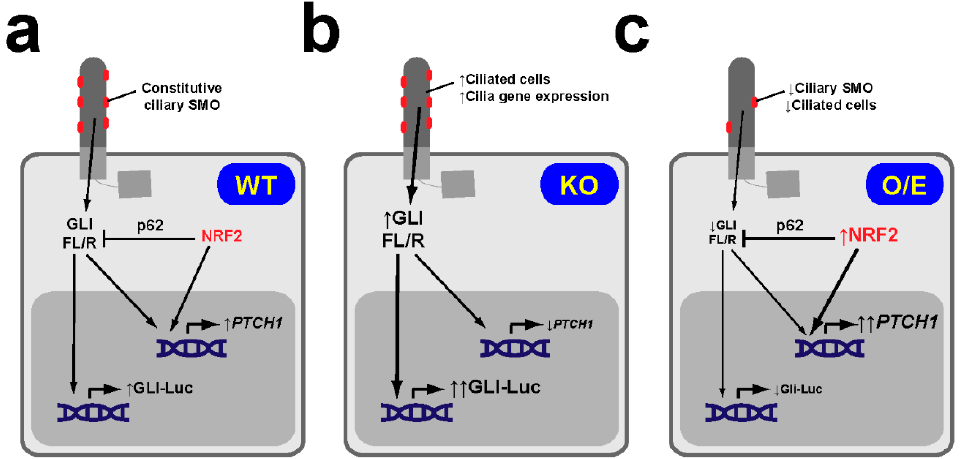
Figure 6. NRF2 downregulates basal Hh pathway activity in NSCLC cells. ( a ) In NRF2 WT NSCLC cell lines like H1299, SMO localizes constitutively at cilia, indicative of active Hh signaling. In these cells, NRF2 levels are low, as are its e ff ects on both PTCH1 gene expression (which it activates via an ARE in its promoter) and GLI factors (whose full length-to-repressor ratios (FL / R) and transcriptional activity it downregulates via p62 / SQSTM1). ( b ) In NRF2-null (KO) H1299 cells, lack of NRF2 leads to increased ciliogenic gene expression and increased ciliogenesis, lower PTCH1 levels, higher GLI FL / R ratios and higher GLI-luciferase reporter (Gli-Luc) activity. ( c ) In H1299 cells overexpressing (O / E) NRF2 (or where NRF2 is stabilized by pharmacological or genetic KEAP1 inactivation), ciliogenesis is reduced and PTCH1 is increased, leading to reduced ciliary SMO. Under these conditions, GLI ratios and activity are lower, due to the combined e ff ects of NRF2 on both PTCH1 and p62. Given that PTCH1 is a transcriptional target of both GLI and NRF2, higher PTCH1 levels in these cells suggest that NRF2 activation has a stronger e ff ect on PTCH1 than GLI activity reduction. Similarly, in NRF2 KO H1299 cells ( b ), NRF2 loss predominates over increased GLI activity [59].